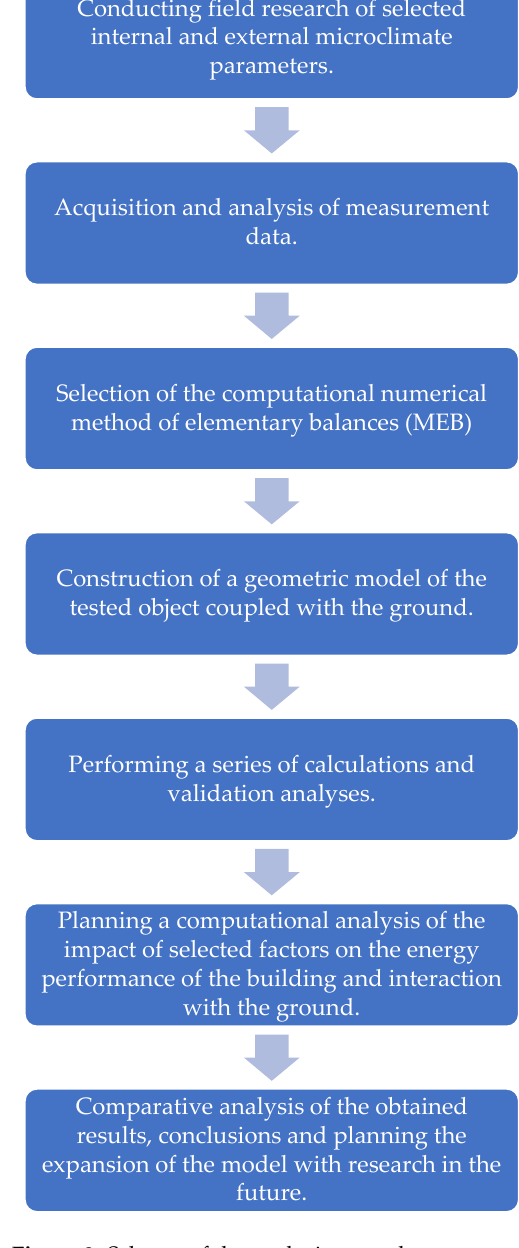
Figure 3. Scheme of the analysis procedure.